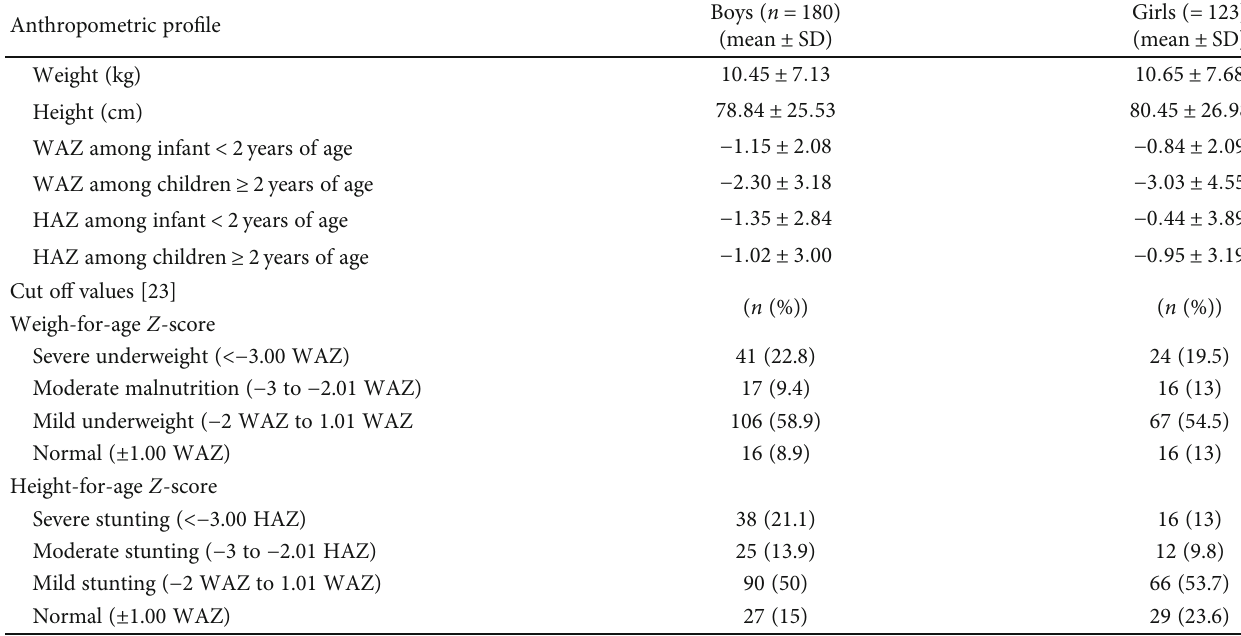
Table 2: Anthropometric pro fi les of patients based on gender ( n = 303